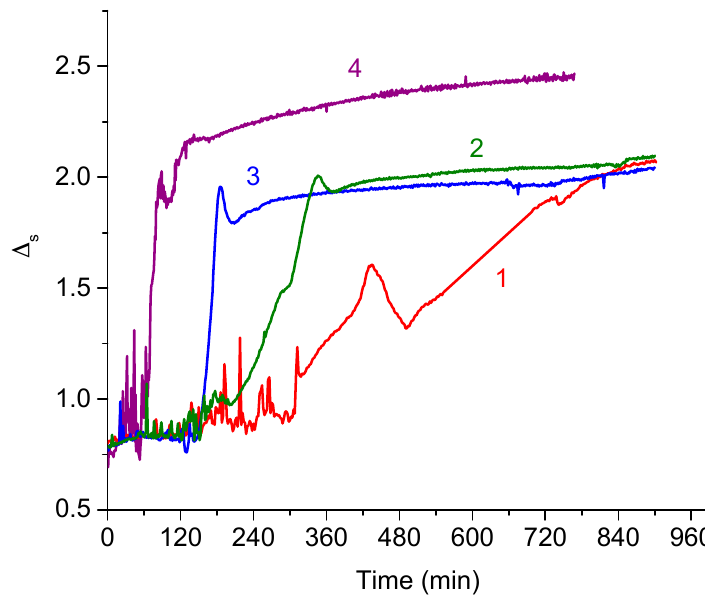
Figure 5. Kinetic dependencies of the ellipsometric angle ∆ s of the PDAHMAC layer after DNA injection into subphase. The total DNA concentrations are 7 (1), 14 (2), 28 (3) and 56 (4) µ M. The initial surface pressure the PDAHMAC layer is 11 mN/m.